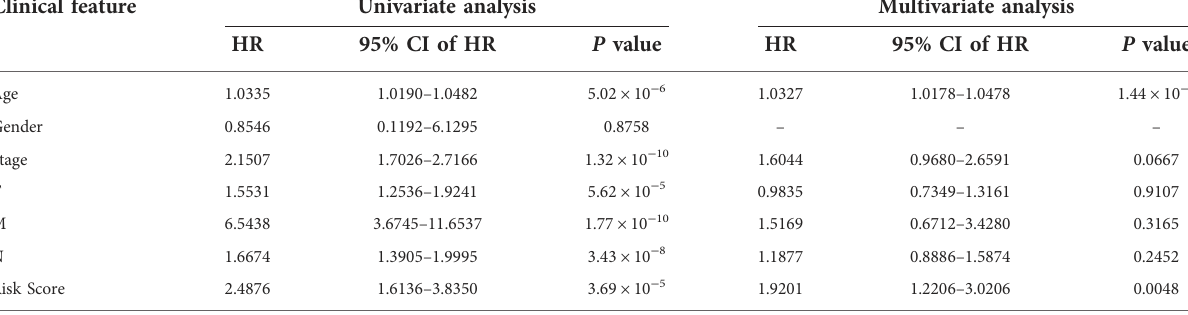
TABLE 3 Univariate and multivariate Cox regression analyses for each clinical feature (TCGA